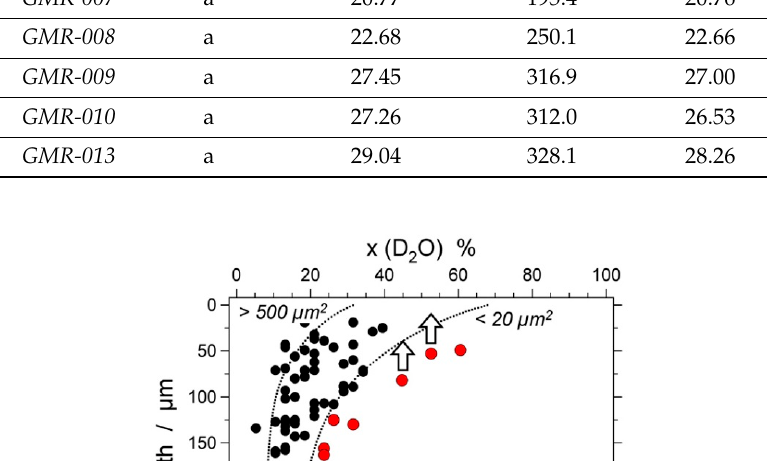
Experiment Disk Table 5. Average D 2 O molar volume ( V m ) in the experimental conditions and corrected values of homogenization temperatures and molar volumes in homogenization conditions according to the quartz expansivity and compressibility [20] along the isochores in re-equilibration experiments. Corrected Values Experiment Disk V m (cm 3 /mol)